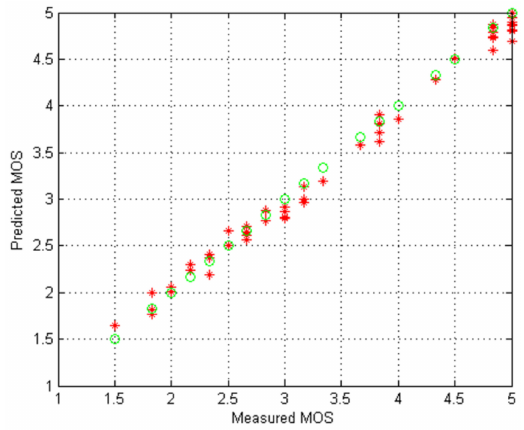
Figure 18. Subjective MOS vs. predicted MOS for